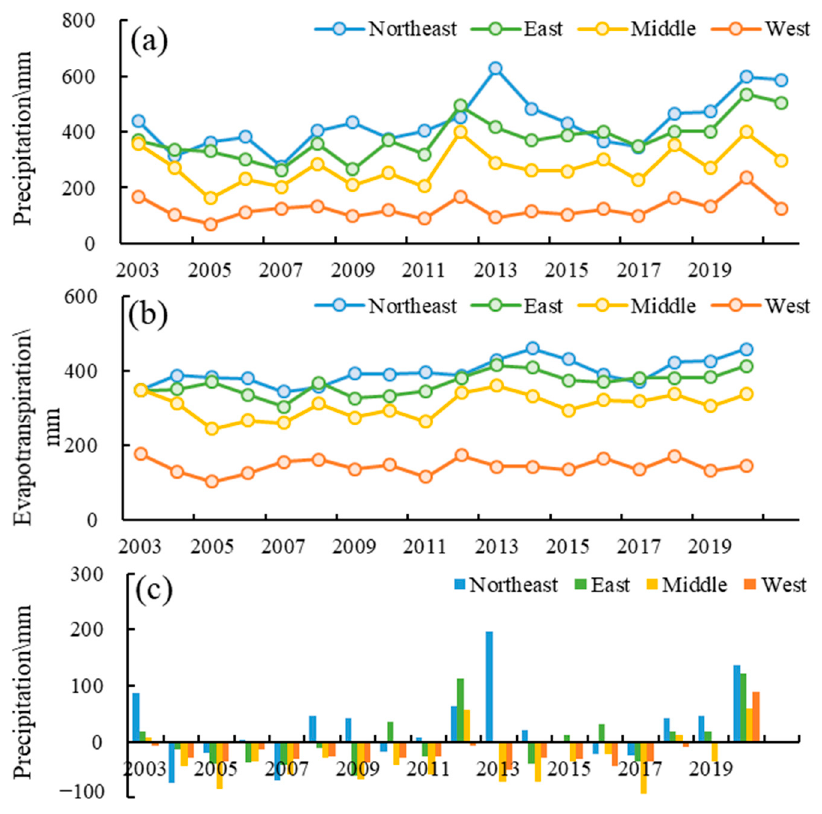
Figure 6. The climate conditions in Inner Mononlia (( a ) precipitation in 2003–2021, ( b ) evapotran- spiration in 2003–2020, ( c ) net precipitation recharge in 2003–2020 (Northeast: Northeast climate zone; East: East climate zone; Middle: Middle climate zone; West: East climate zone;)).